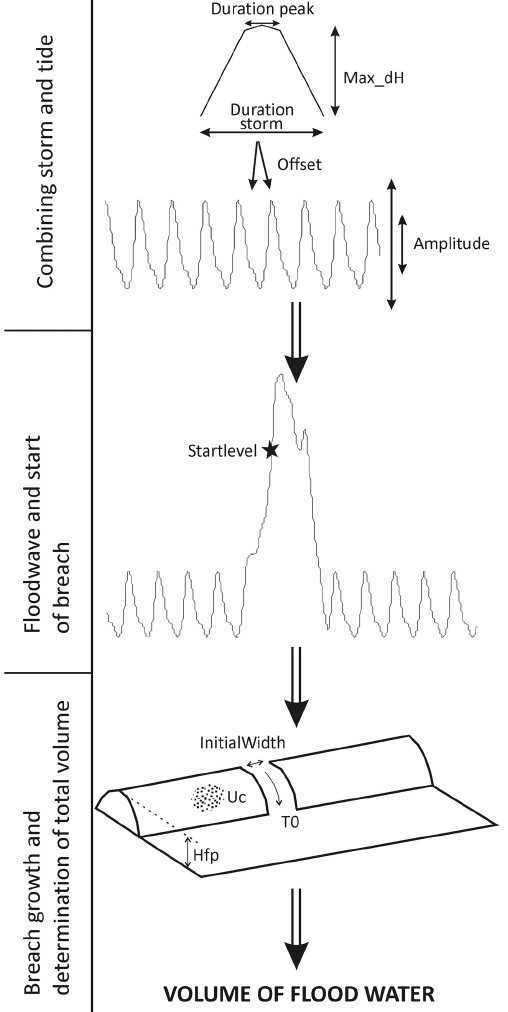
Fig. 3. Schematic representation of the volume calculation part of the modelling chain (going from top to bottom). The different pa- rameters shown have been varied in the Monte Carlo analysis in this study.